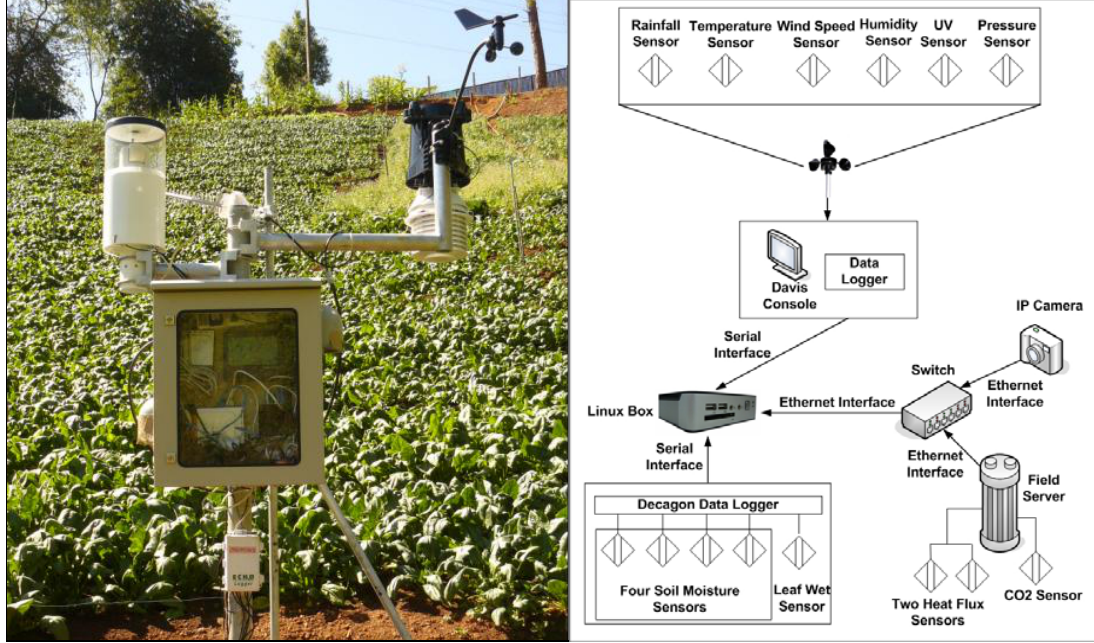
Figure 8. Crop monitoring field sensor network setup near Chiang Mai, Thailand.